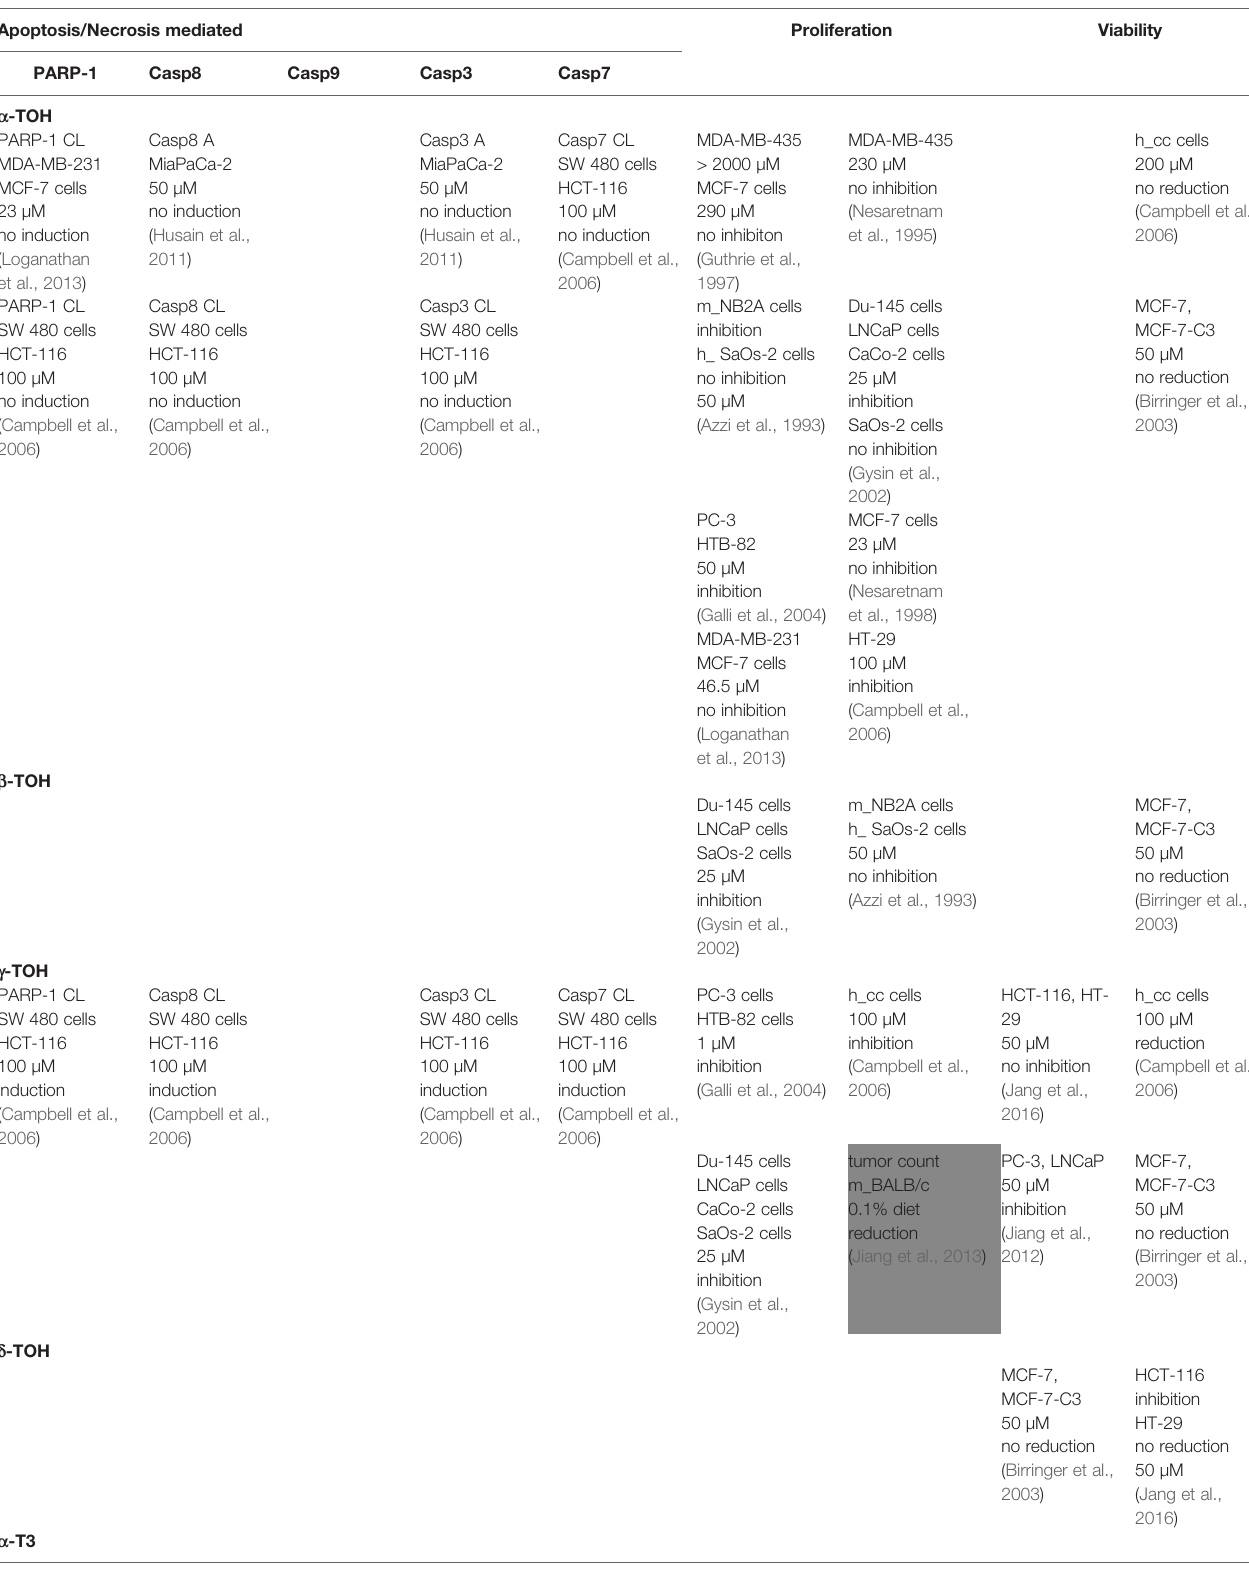
TABLE 3 | Overview on the biological activities of chromanols linked to